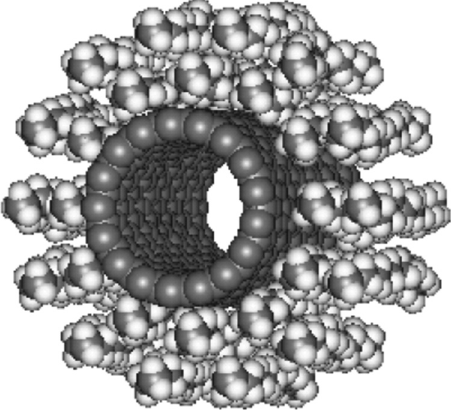
Figure 2 Computational model of single-walled nanotube surrounded by layers of polyethylene